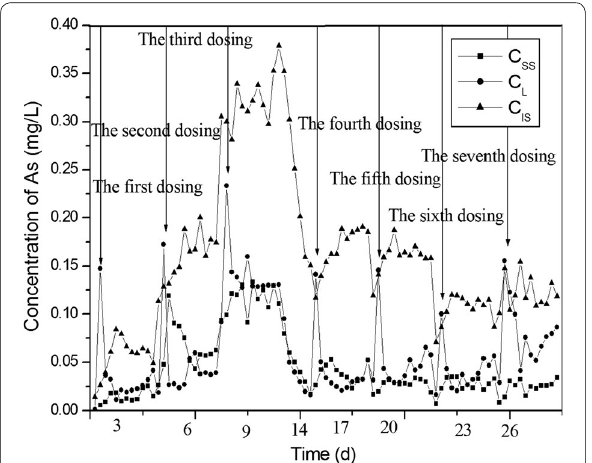
Fig. 3 The distribution of As in continuous flow activated sludge reactor. CL concentration of As in water, CSS concentration of As in the surface of solid, CIS concentration of As in the interior of solid Fig. 4 The removal of As in continuous operation